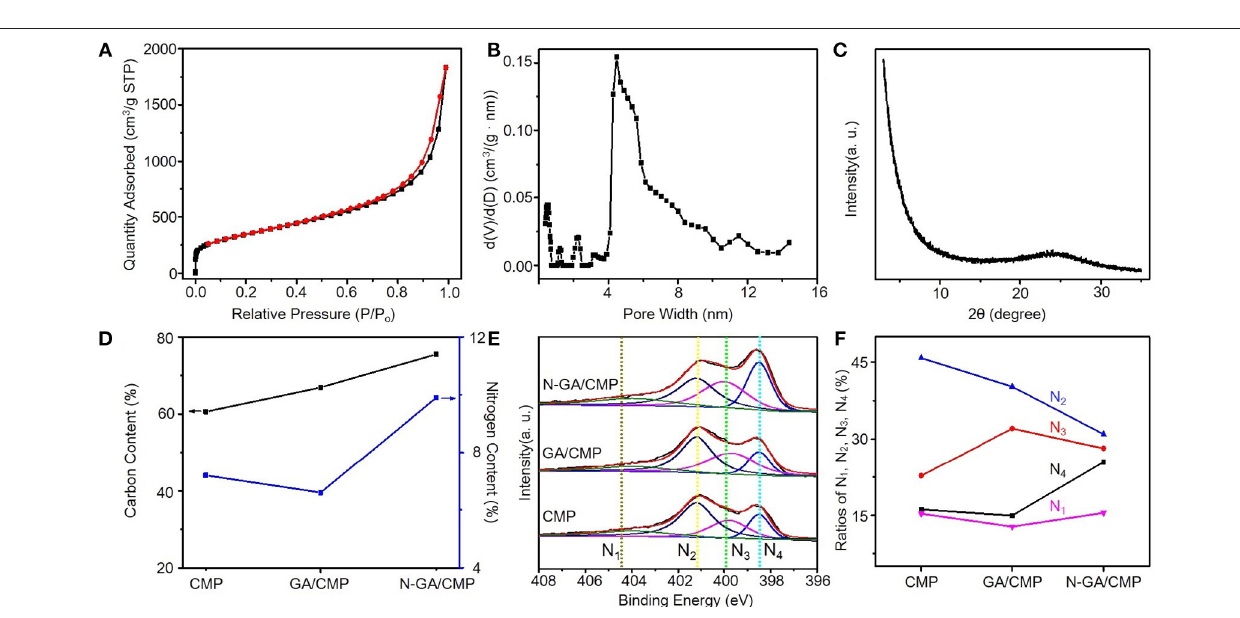
Frontiers in Chemistry | www.frontiersin.org